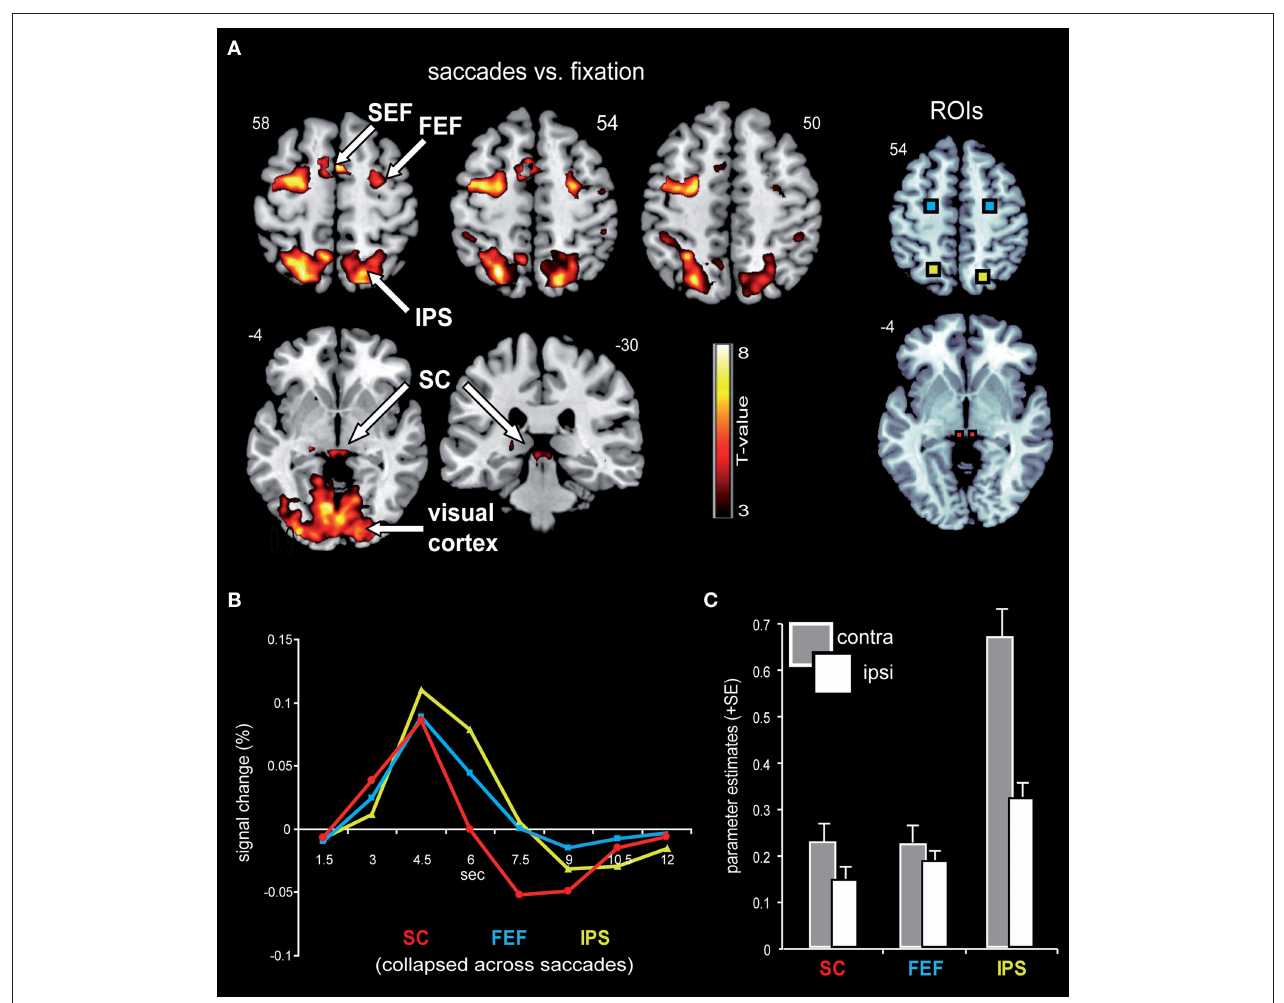
the selected ROIs, namely the SC (depicted in red), FEF (blue), and IPS (yellow) are displayed averaged across all saccade trials and both hemispheres. (C) The collapsed ROI-based parameter estimates (beta) for leftward and rightward saccades with respect to the hemisphere contra- and ipsilateral to saccade direction revealed a relative activity enhancement in the contralateral (gray bars) as compared to the ipsilateral (white bars) hemisphere within SC, FEF, and